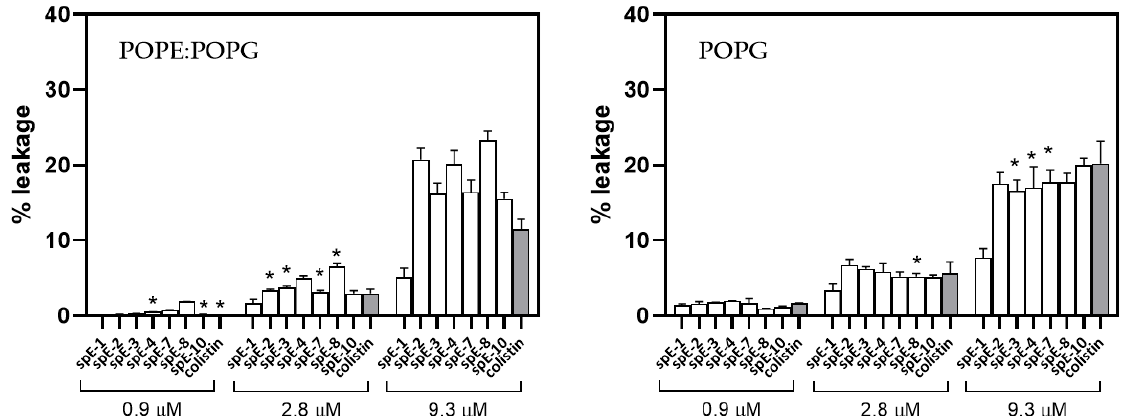
Figure 7. Leakage from vesicles of POPE/POPG ( left ) or POPG ( right ) at three peptide concentrations. Lipopeptides were added to liposomes co-encapsulating ANTS (12.5 mM) and DPX (45 mM), and leakage was determined as the increase in ANTS fluorescence intensity at 530 nm (excitation 350 nm, lipid concentration 107 µM). Data represent the mean ± SD (n = 3). Concentrations close to the MIC are marked with an asterisk.